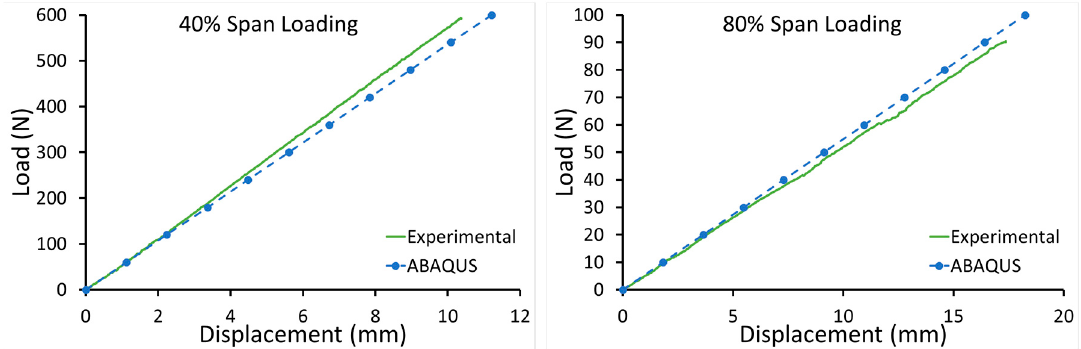
Figure 4. Comparison of ABAQUS FEA structural model and cantilever fin test results.